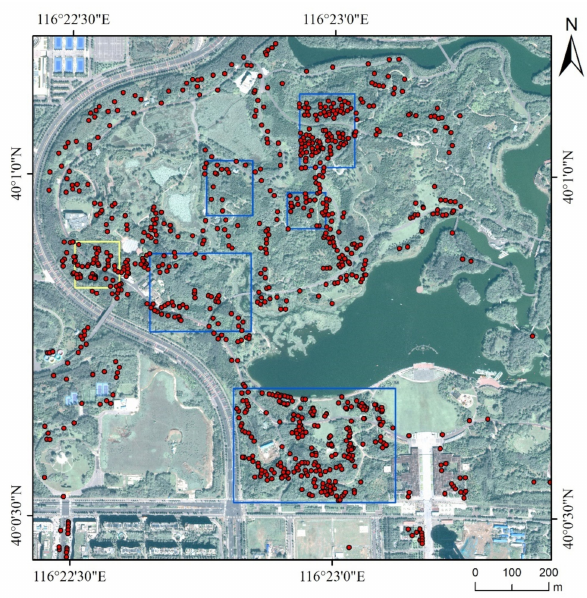
Figure 3. Locations of tree species samples (red dots) identified during the field investigation. Training sample collection regions (blue rectangles) and the test sample collection region (yellow